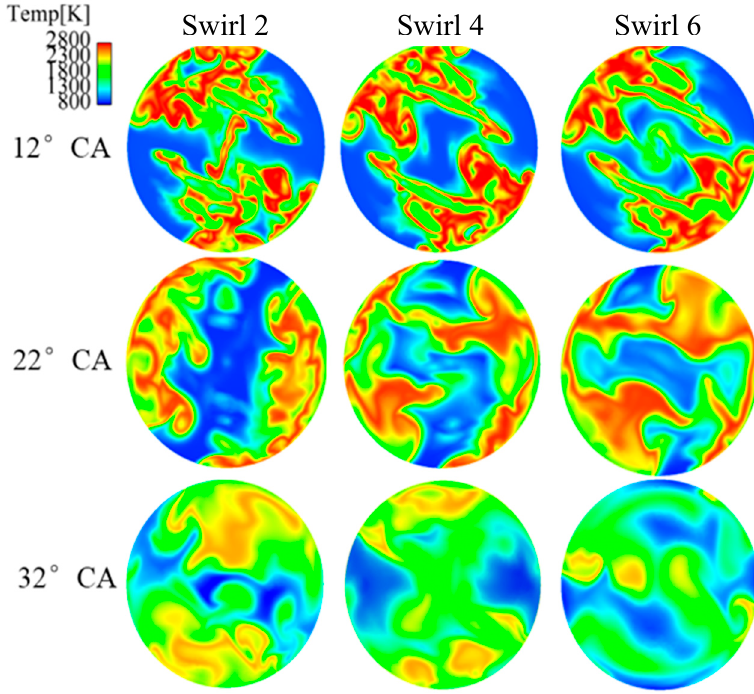
Figure 15. Distribution of cylinder temperature under different swirl ratios.